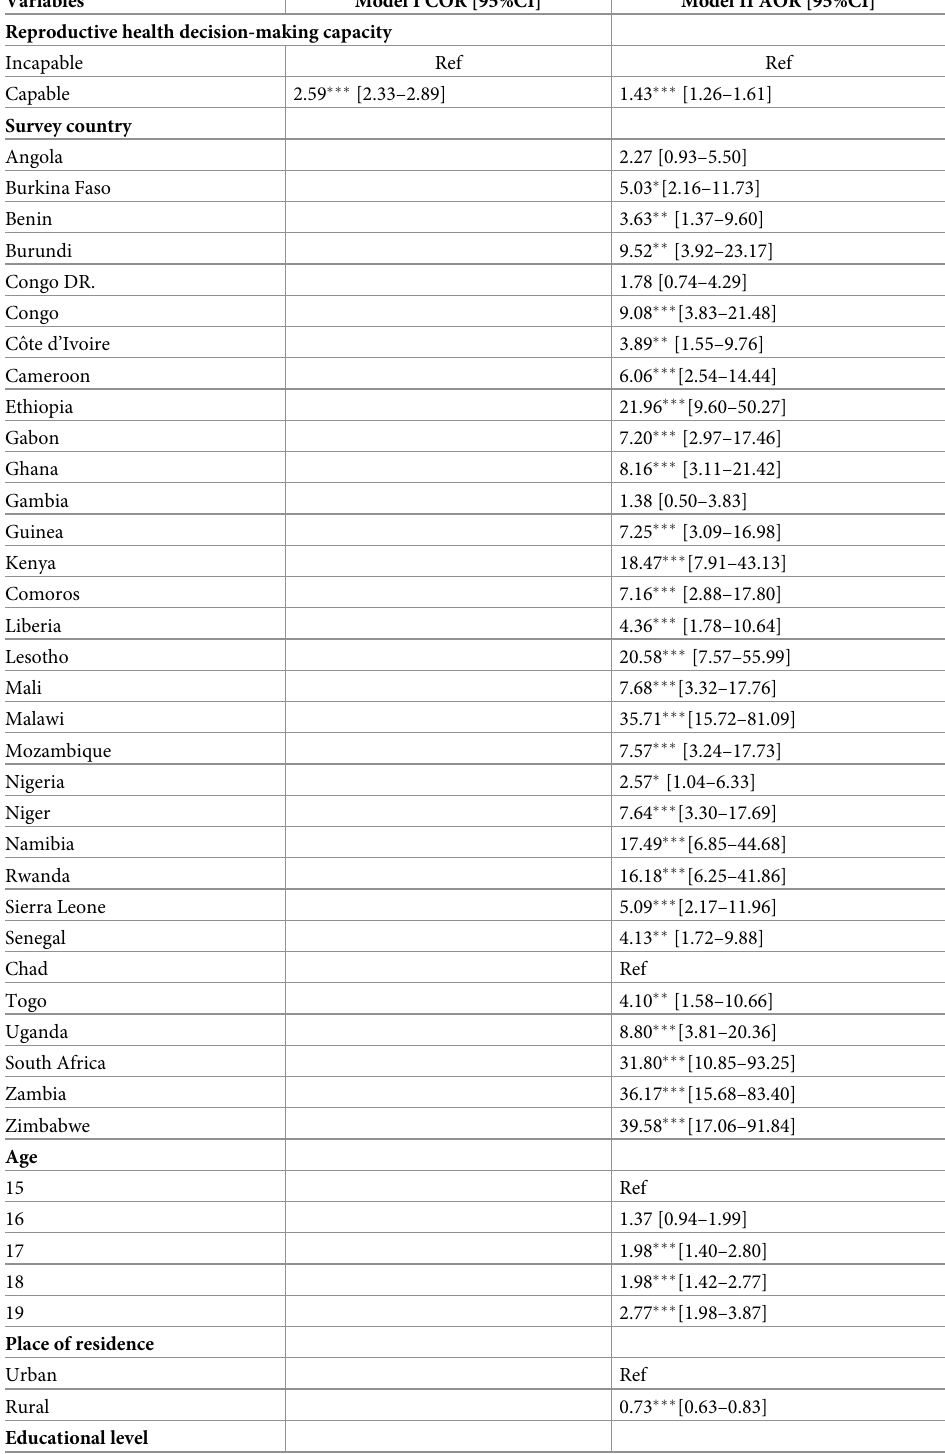
Table 4. Binary logistic regression analysis on female adolescents’ reproductive health decision-making capacity and modern contraceptive